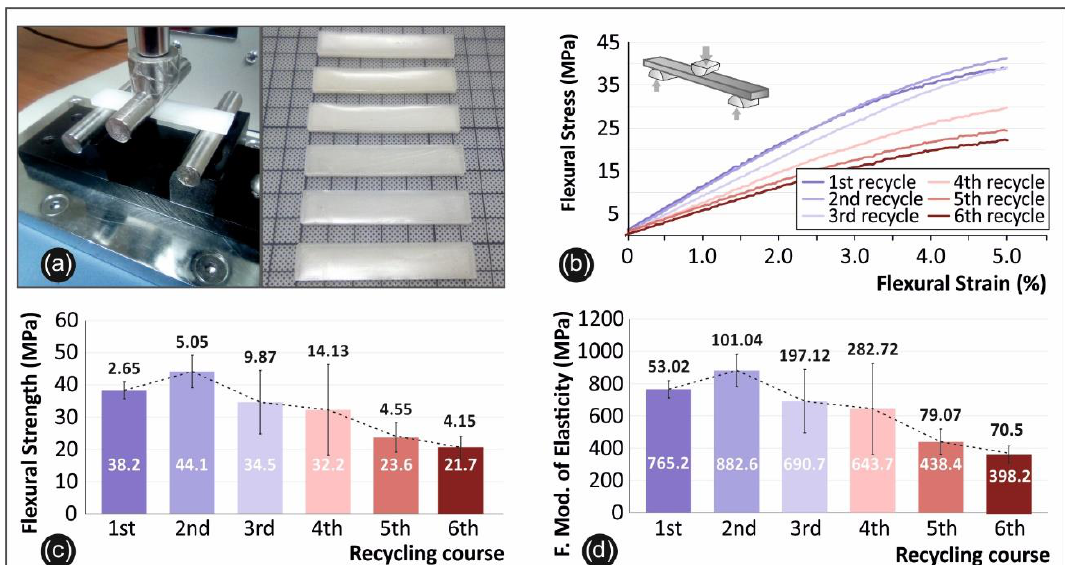
Figure 5. Flexural tests: ( a ) device experimental setup and specimens after the test, ( b ) stress strain graphs from the no 2 specimen of each recycle course, ( c ) comparison of the flexural strength average values along with the calculated deviation from each recycle course studied, and ( d ) comparison of the flexural modulus of elasticity average values along with the calculated deviation from each recycle course studied.